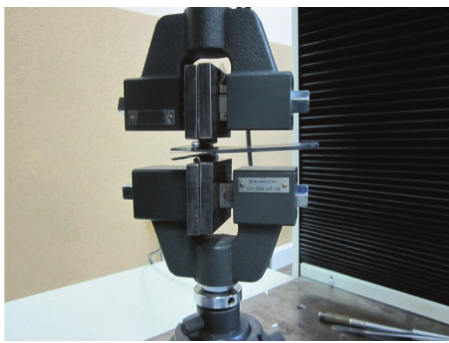
Figure 9 DCB specimen for mode I testing mounted on the fixture.